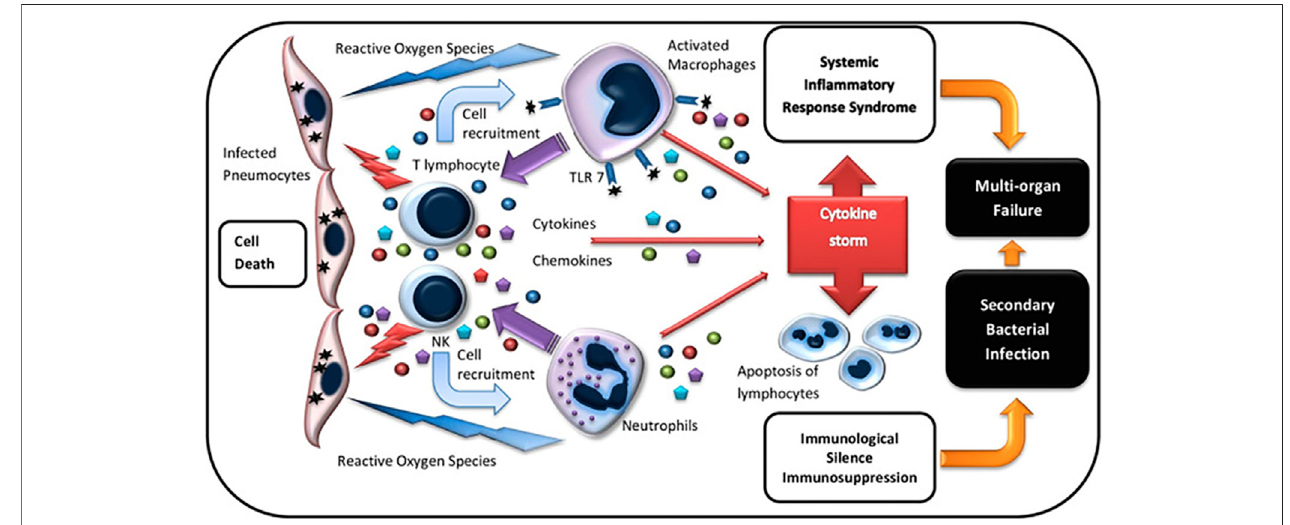
FIGURE 1 | | Immunopathogenesis of cytokine storm (Kiselevskiy et al., 2020).